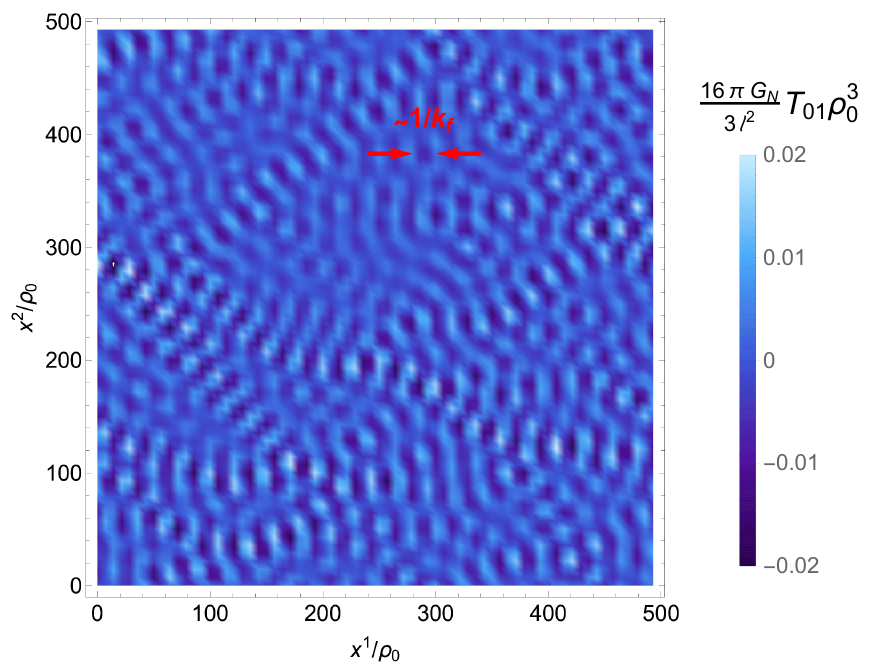
Figure 1 . A snapshot of the energy flux, T 01 ( t, x 1 , x 2 ) at t = 750 ρ 0 where ρ 0 = 3 / (4 πT ) and T 0 is the temperature prior to the onset of the driving force. The typical scale we observe is of the same order as the driving scale, 1 /k f